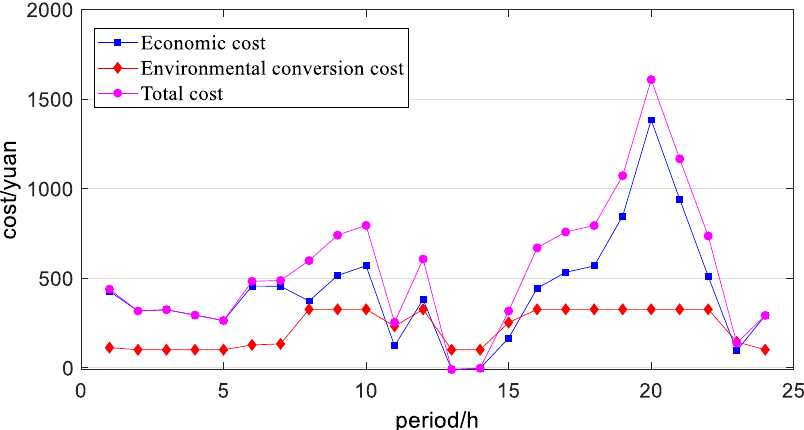
Figure 7. Operating cost curve of the IES for each period of a typical winter day.